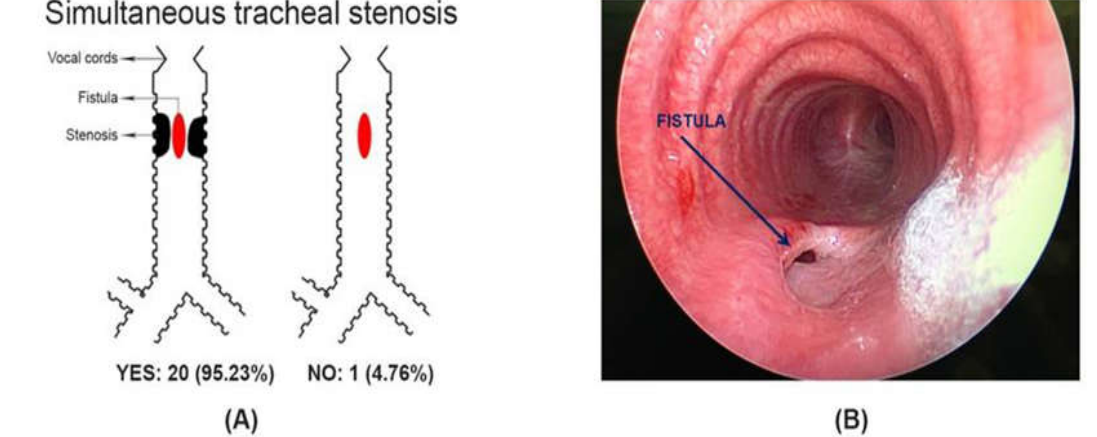
Figure 1. A- Simultaneous tracheal stenosis. B- Endoscopic view of a fistula without concomitant tracheal